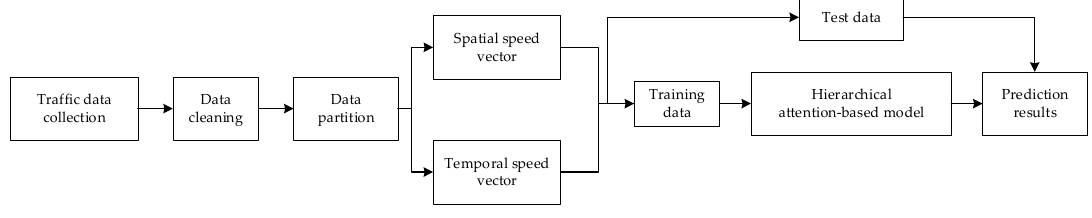
Figure 1. Framework of the proposed method.